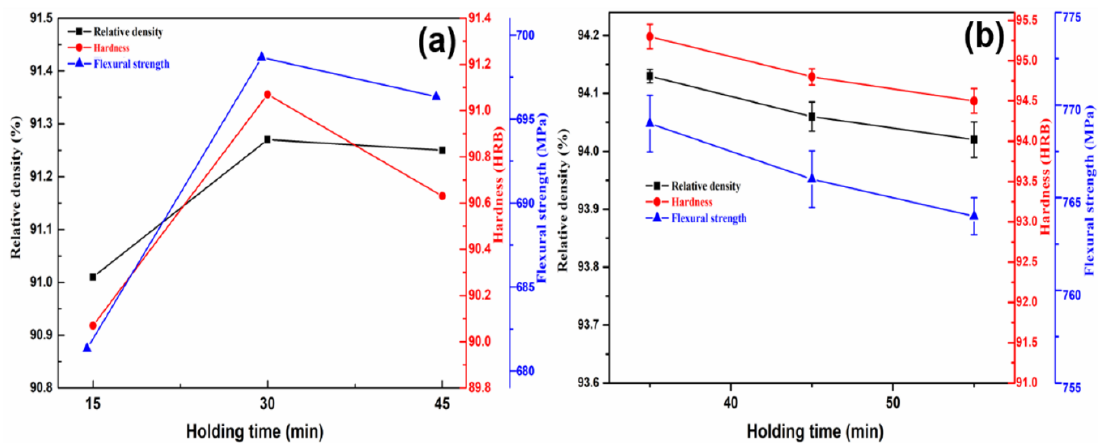
Figure 4. The effect of holding time on the mechanical properties of the samples (( a ) Orthogonal experimental; and ( b ) Conditional experiment (880 °C, 375 MPa)).